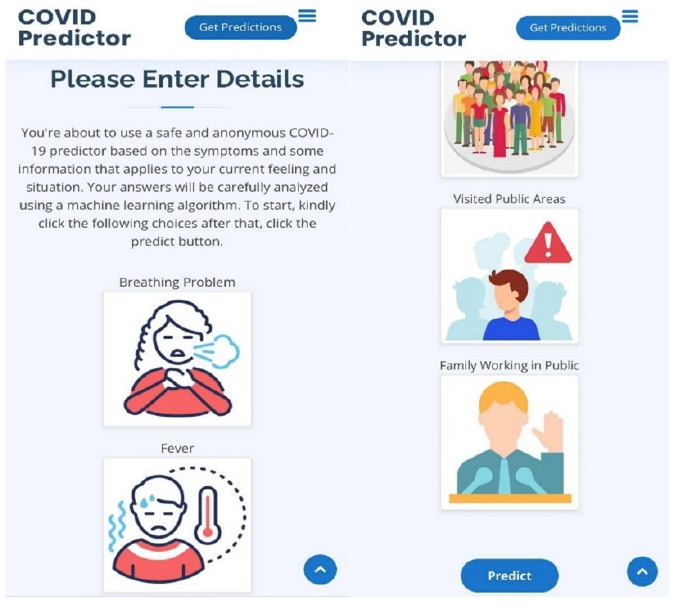
Figure 16. The COVID-19 prediction section responsive view section using a mobile device.